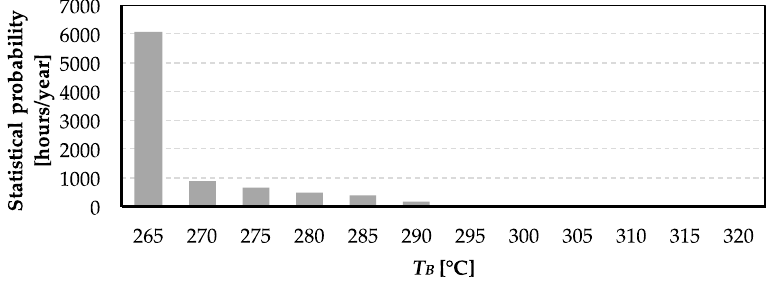
Figure 8. Statistical distribution of the battery internal temperature T B , in comparison with the admitted range T m / T M .